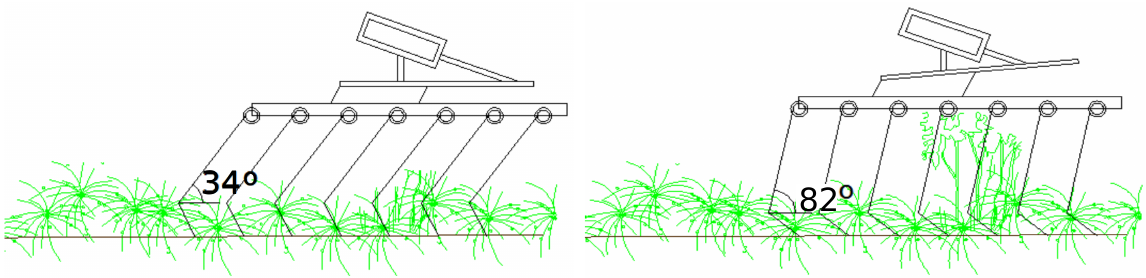
Figure 3. Schematic of the tine angle used, creating a low harrowing intensity (left) and a high harrow intensity